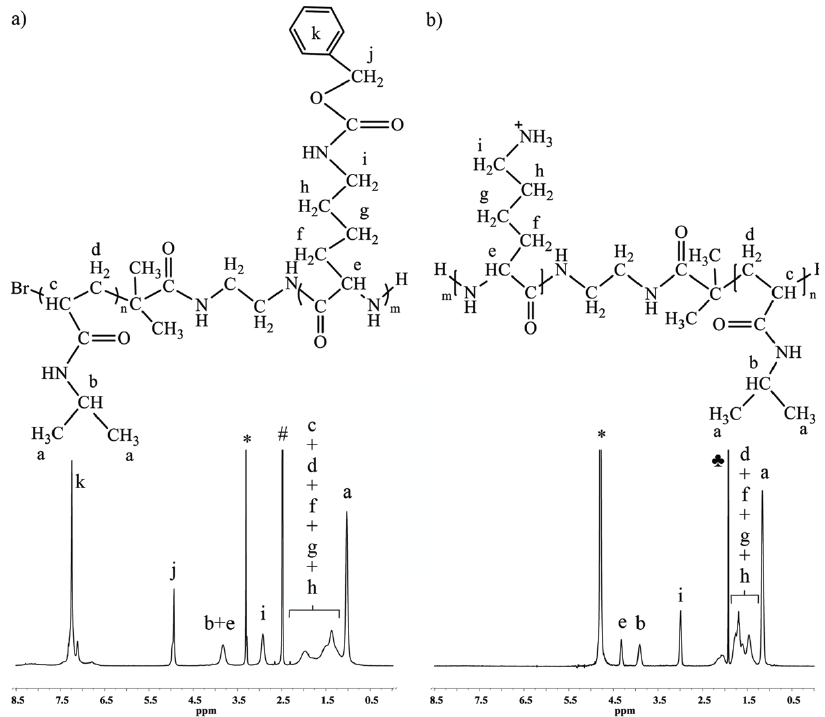
Figure 4. 1 H-NMR spectra of PLL ( a ) before and ( b ) after treatment with HBr in acetic acid. The spectra were recorded with relaxation delay of 12 s, 32 scans in DMSO-d6 ( a ) and D O ( b ), # DMSO-d6; * water; ♣ residues of acetic 2